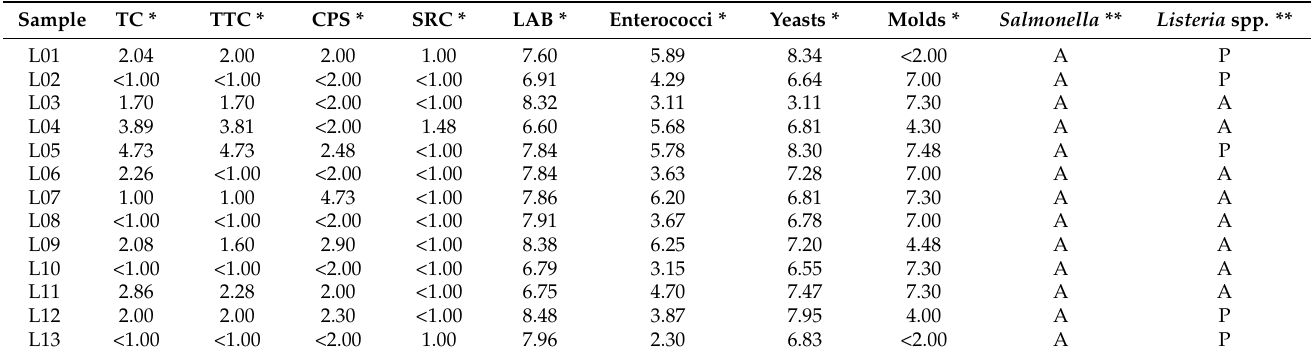
Table 2. Microbial analyses of Colonial salami-type dry-fermented